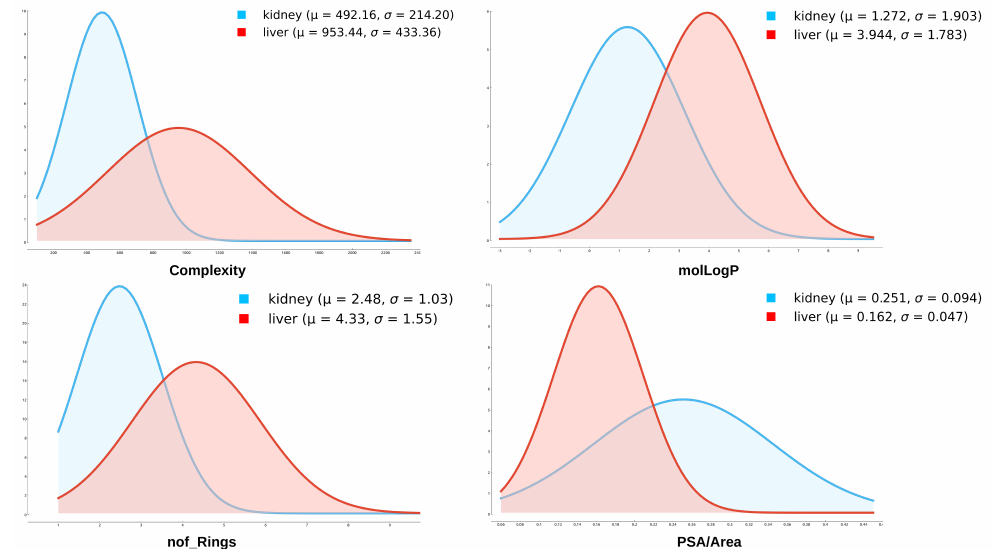
Figure 1. Distribution plots of molecular properties of small organic anion drugs interacting with liver OATPs (SLCO1B1, SLCO1B3, or both) versus kidney OATs (SLC22A6, SLC22A8, or both). Distributions of several molecular properties were analyzed for liver OATPs and kidney OATs.